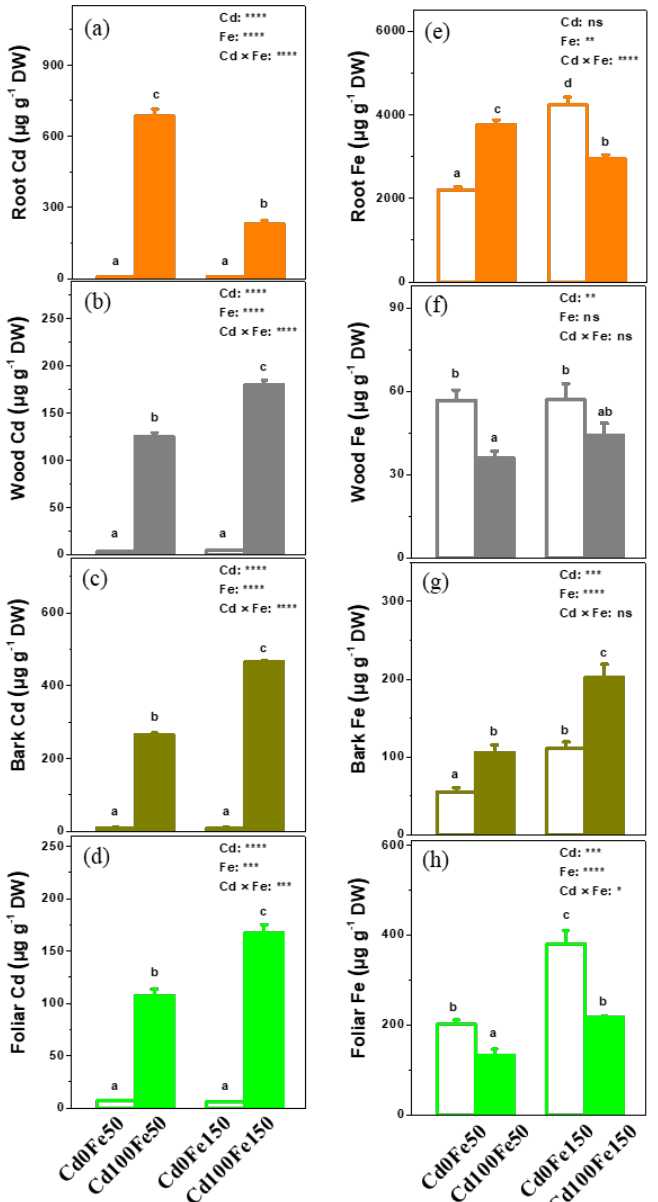
Figure 6. The Cd ( a – d ) and Fe ( e – h ) contents in the roots, woods, barks, and leaves of poplar under different Cd and Fe combined treatments. Data were means ± SE (n = 6). Different lowercase letters on the bars indicate significant differences in ANOVA ( p < 0.05). p values of two-way ANOVA on Cd, Fe, and their interaction (Cd × Fe) were indicated (*, p < 0.05; **, p < 0.01; ***, p < 0.001; ****, p < 0.0001; ns, not significant).